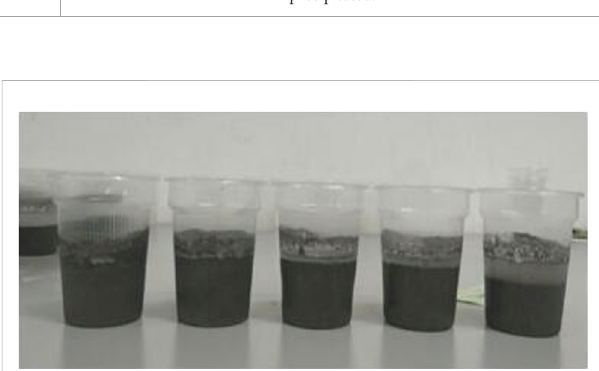
FIGURE 4 Comparison of water precipitation properties of fl y ash colloid fi re extinguishing agent with different concentrations (From left to right, the concentration ratios of fl y ash to water are 1:1, 1:1.5, 1:2, 1: 2.5 and 1:3,